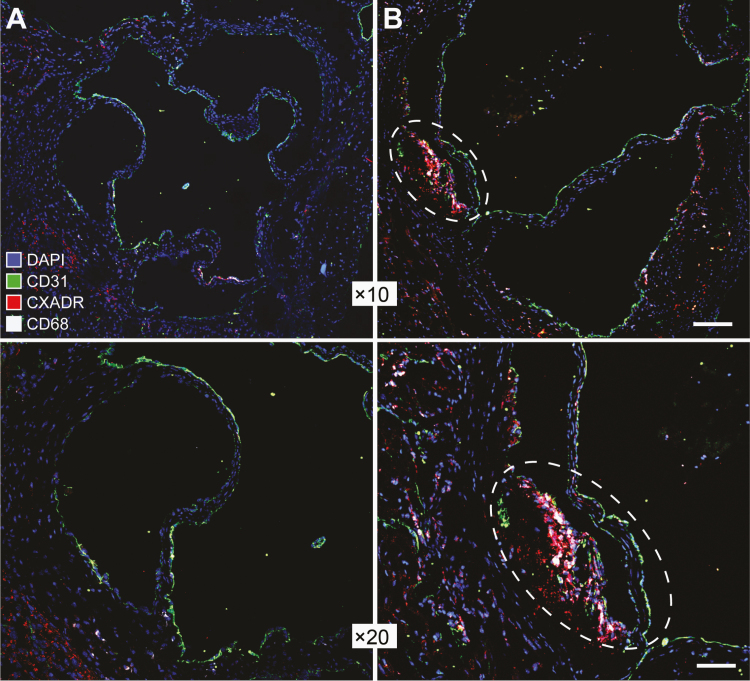
Up-regulation of coxsackievirus and adenovirus receptor (CXADR) in aortic plaques in a mouse model of atherosclerosis. Representative immunofluorescent images showing staining of CXADR (red) in aortic walls from 10-week-old (A) or 50-week-old (B) Ldr−/−Apob100/100 mice. Endothelial cells and macrophages were stained with antibodies against CD31 (green) and CD68 (white), respectively. Cell nuclei were labeled with DAPI (blue). A plaque lesion in the aortic wall of a 50-week-old mouse is enclosed in a dashed oval (right-hand images). Images were obtained with a digital camera and processed with NIS-Elements software (version 4.0; https://www.microscope.healthcare.nikon.com/products/software/nis-elements). Scale bars represent 60 μm (×10 magnification images) and 30 μm (×20 magnification images).